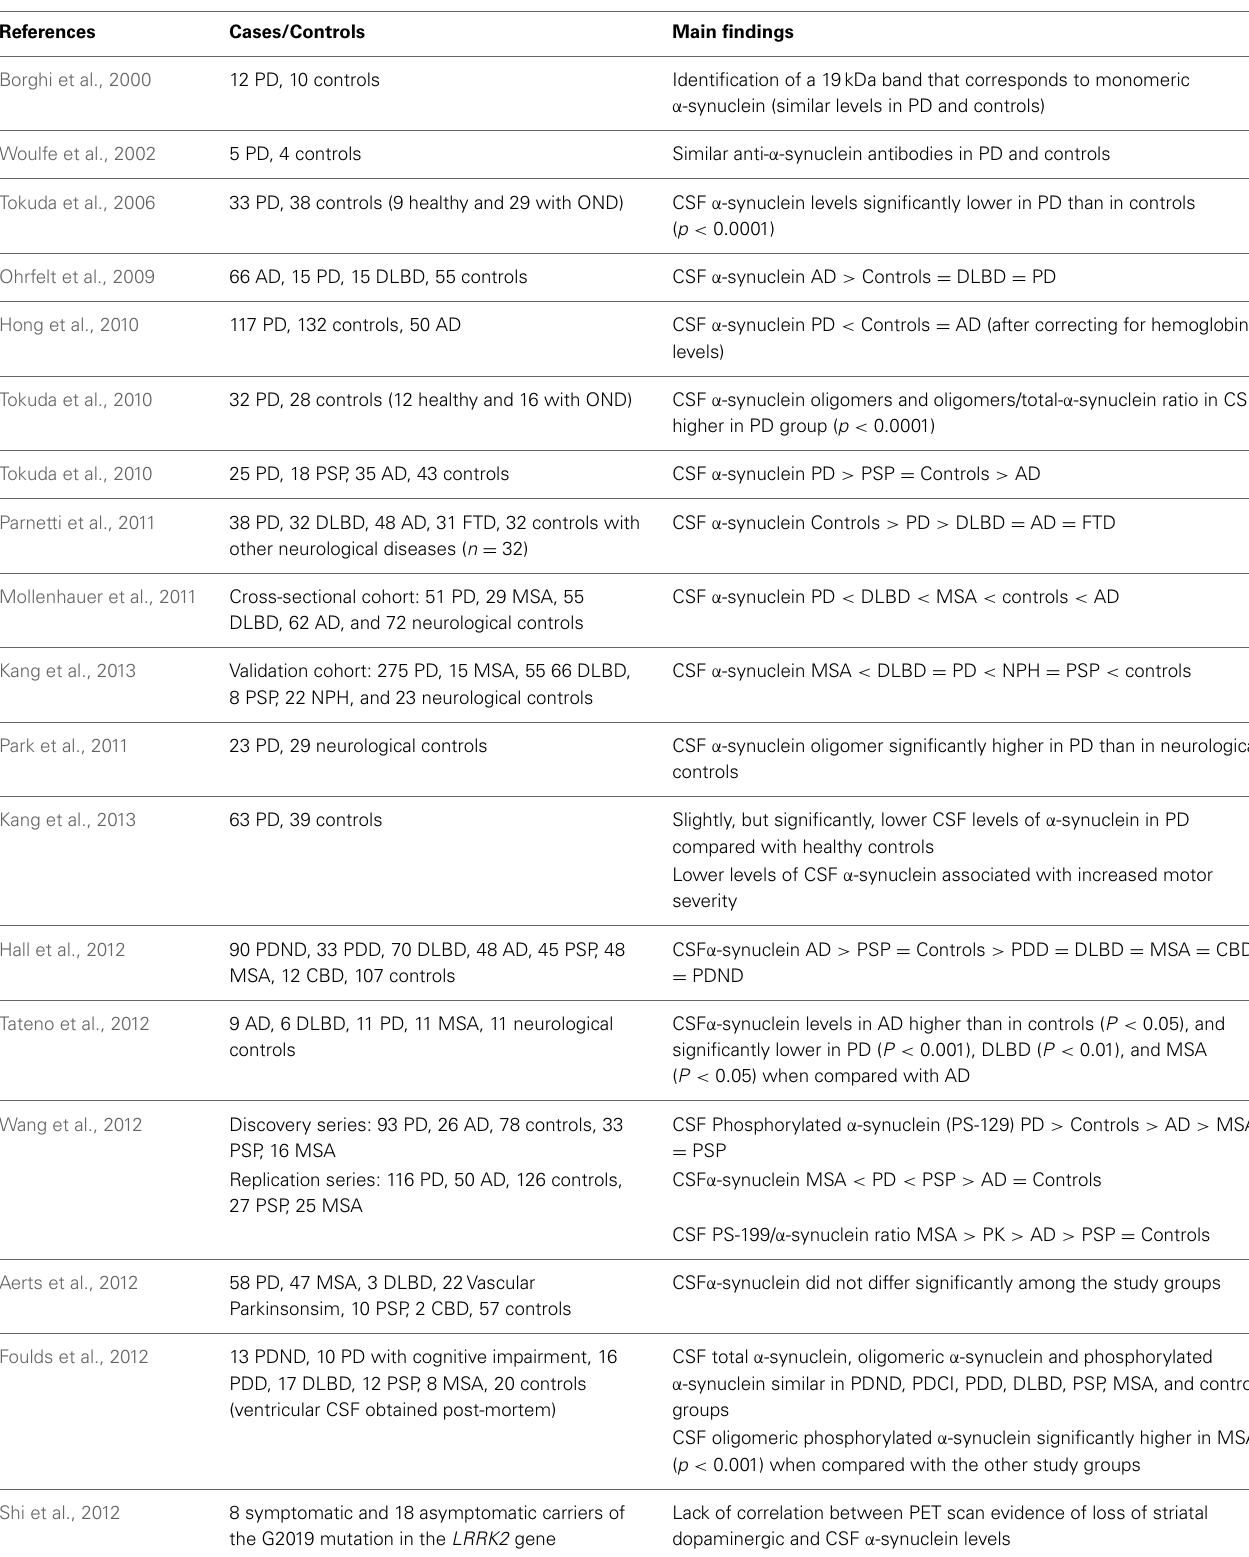
Table 5 | Results of studies on CSF alpha-synuclein and phosphotau levels in PD, other parkinsonian syndromes and